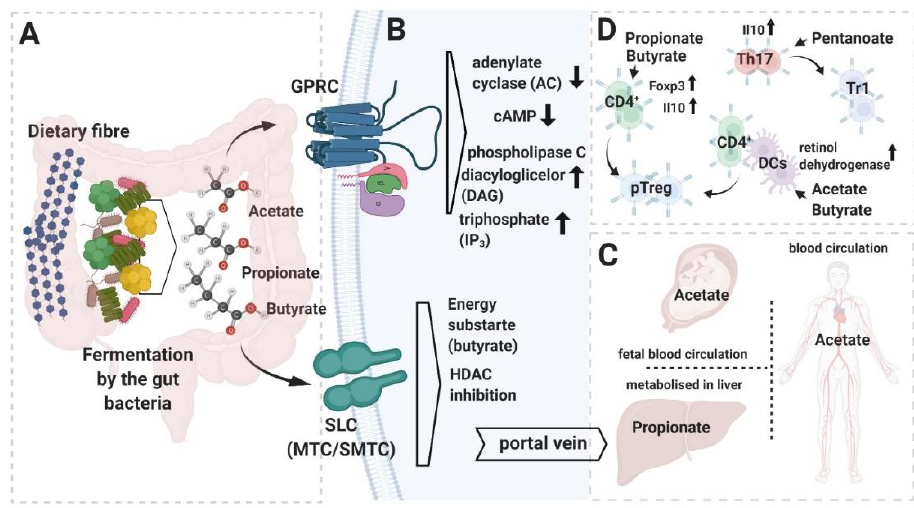
Figure 1. Summary of short chain fatty acids (SCFAs) metabolism and functions. ( A ) Most of the SCFAs are produced in the large intestine upon fermentation of dietary fiber, which is carried out by the host microbiome’s bacterial members. ( B ) SCFAs can activate cell-intrinsic cascades through the g-protein-coupled receptors (GPCRs) (upper panel) or affect transcription of the genes upon inhibition of histone deacetylases HDAC (lower panel). In the gut, SCFAs, after transport into the colonocytes’ intracellular compartment (mostly through monocarboxylate transporter channels (MTC) and sodium-coupled monocarboxylate transporters (SMCT)), are utilized as an energy substrate (butyrate) or channeled further to the blood circulation through the portal vein. ( C ) Systemic distribution of SCFAs. ( D ) Impact of the different SCFAs on T cell lineage polarization. Graphic created with BioRender.